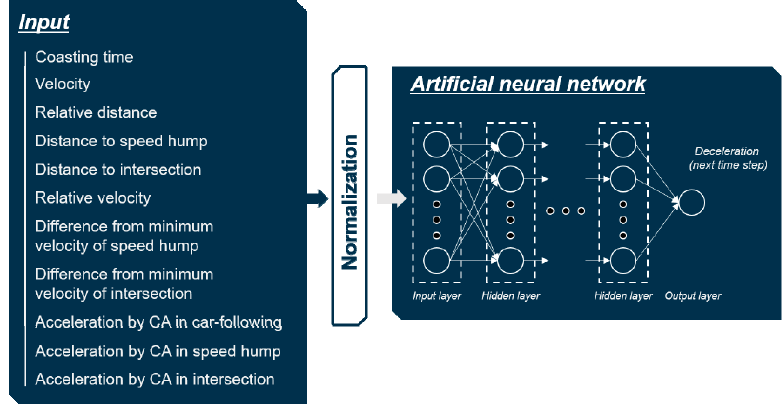
Figure 20. Model structure of integrated MLP model.